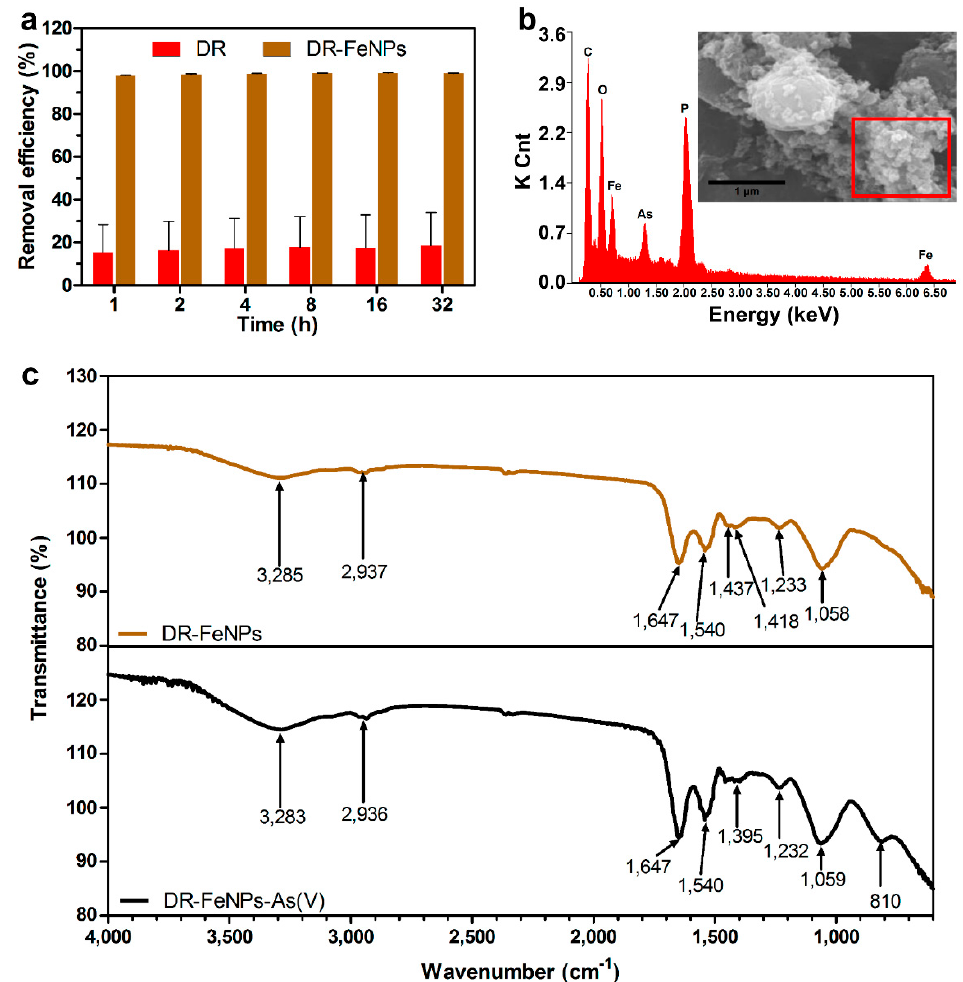
Figure 6. ( a ) Removal efficiency of D. radiodurans R1 (DR) and iron nanoparticle immobilized D. radiodurans R1 (DR-FeNPs). Experimental condition: initial pH = 3, biomass = 0.25 g/L, initial concentration of As(V) = 50 mg/L. All experiments were performed in triplicate; error bars denote standard deviation. ( b ) SEM-EDX analysis of DR-FeNPs with As(V) [DR-FeNPs-As(V)]. ( c )